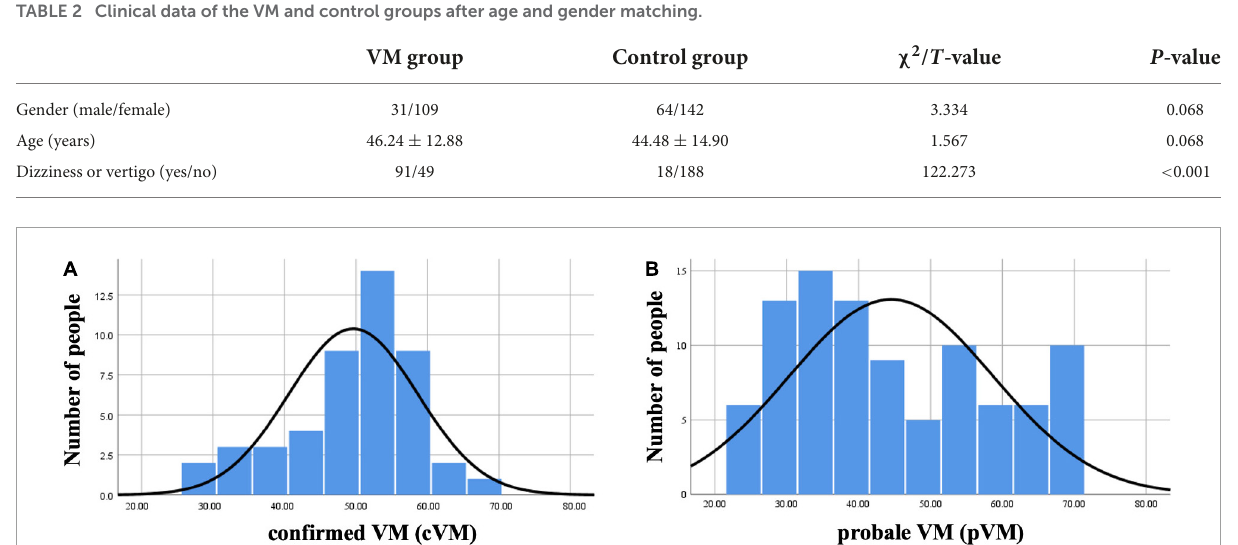
FIGURE1 Histogram of the age distribution of VM in the cVM group and the pVM group. (A) Histogram of the age distribution of the cVM group. (B) Histogram of the age distribution of the pVM group.